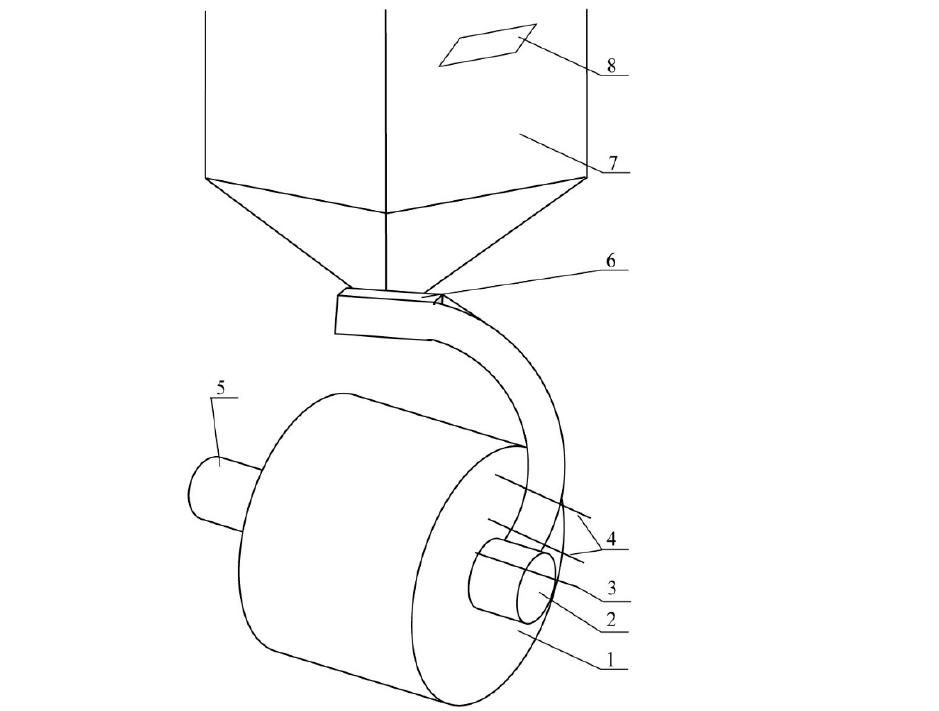
Figure 2. A simplified scheme of a test stand for combustion of biomass pellets: 1—combustion chamber, 2—burner Platinum Bio, 3—flue gas analyzer, 4—thermocouples, 5—gas outlet, 6—fuel feeder, 7—fuel tank, and 8—boiler operation controller.